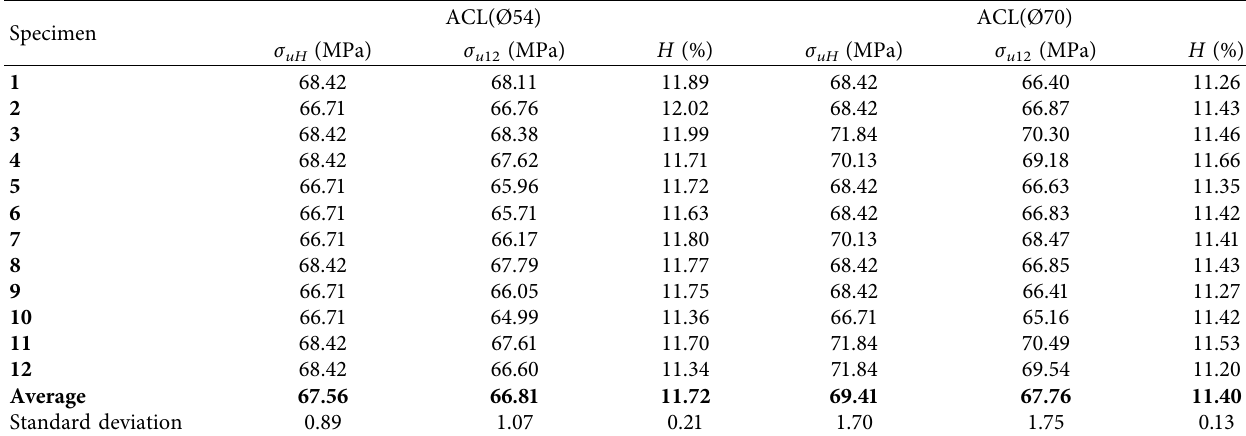
Figure 11: Variation curve of the 4-point bending modulus of elasticity as a function of Table 4: Failure stresses in axial compression, diameter 54cm and 70cm.